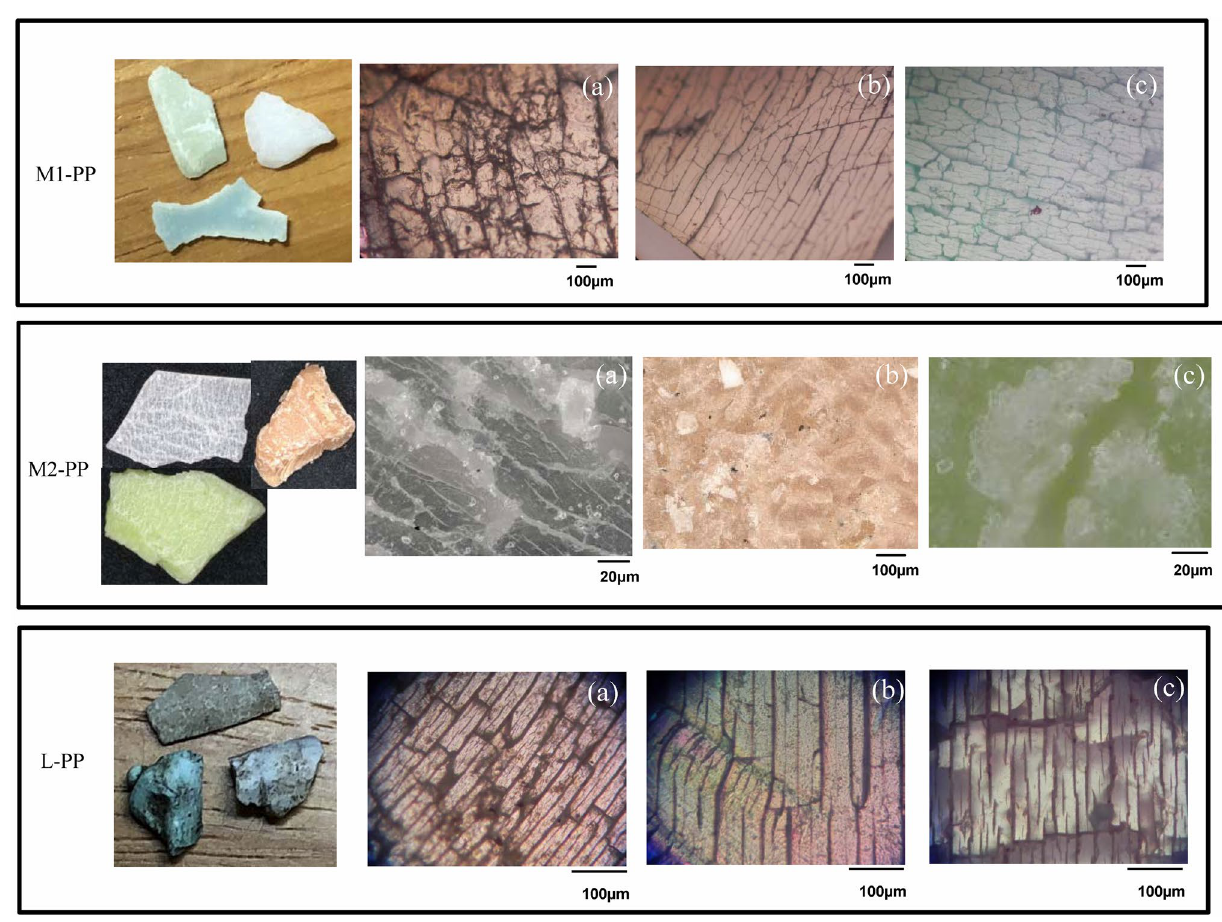
Fig. 2 Photographs, POM and microphotographs of M1-PP, M2-PP and L-PP. M1-PP and L-PP: POM. M2-PP: